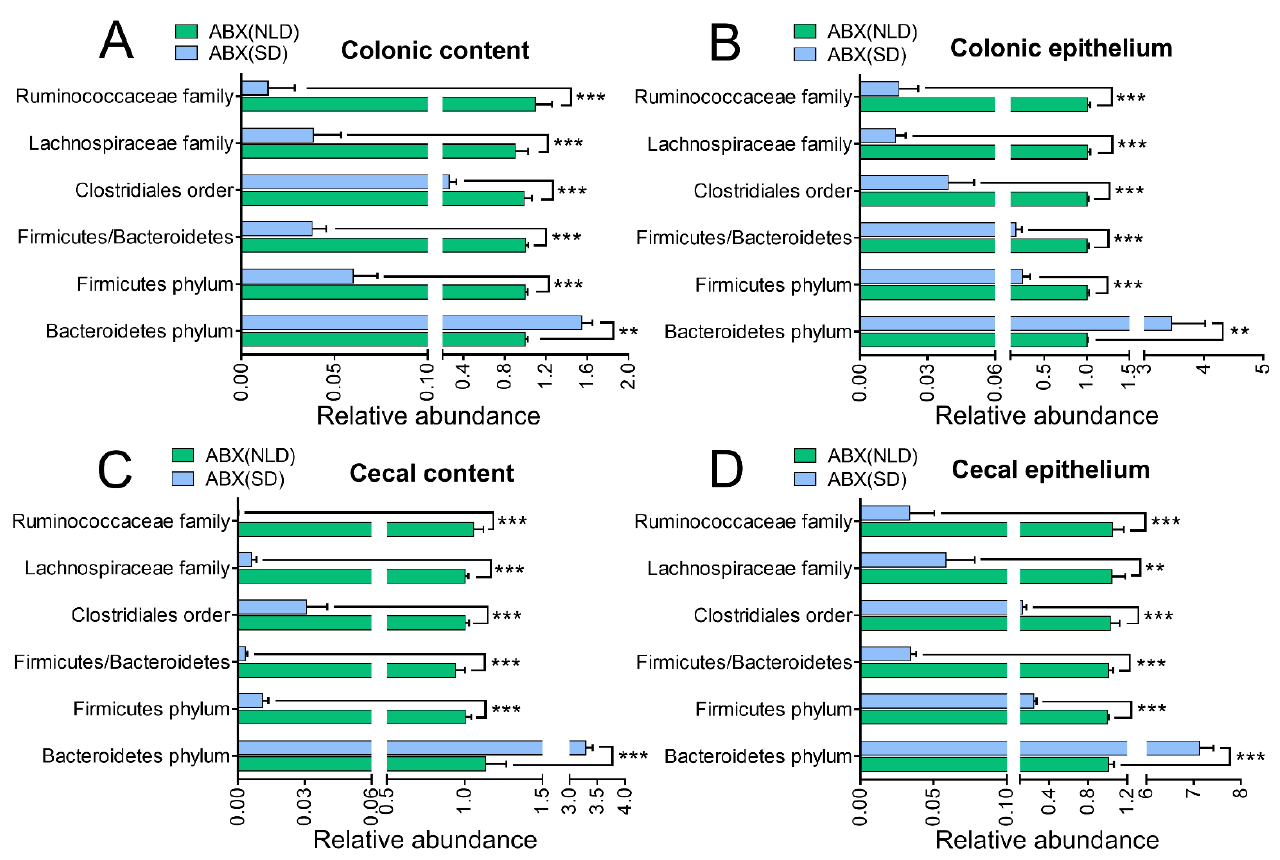
Figure 3. The relative abundance of gut microbiota in colonic and cecal contents and epithelium in ABX mice under NLD and SD. ABX (NLD), the antibiotic-treated mice managed under normal light–dark cycle; ABX (SD), the antibiotic-treated mice managed under short-day cycle. Representative charts of the relative abundance of Bacteroidetes phylum, Firmicutes phylum, Clostridiales order, Lachnospiraceae family, Ruminococcaceae family, and the ratio of Firmicute to Bacteriodetes in colonic content ( A ), colonic epithelium ( B ), cecal content ( C ), and cecal epithelium ( D ) were detected using RT-PCR, where the 16S rRNA gene amplified by the total bacterial primer set was used as an internal reference, and the abundance of gut microbiota in ABX (SD) was relative to ABX (NLD). Values were means, with standard error of the mean. ** p < 0.01, *** p < 0.001.